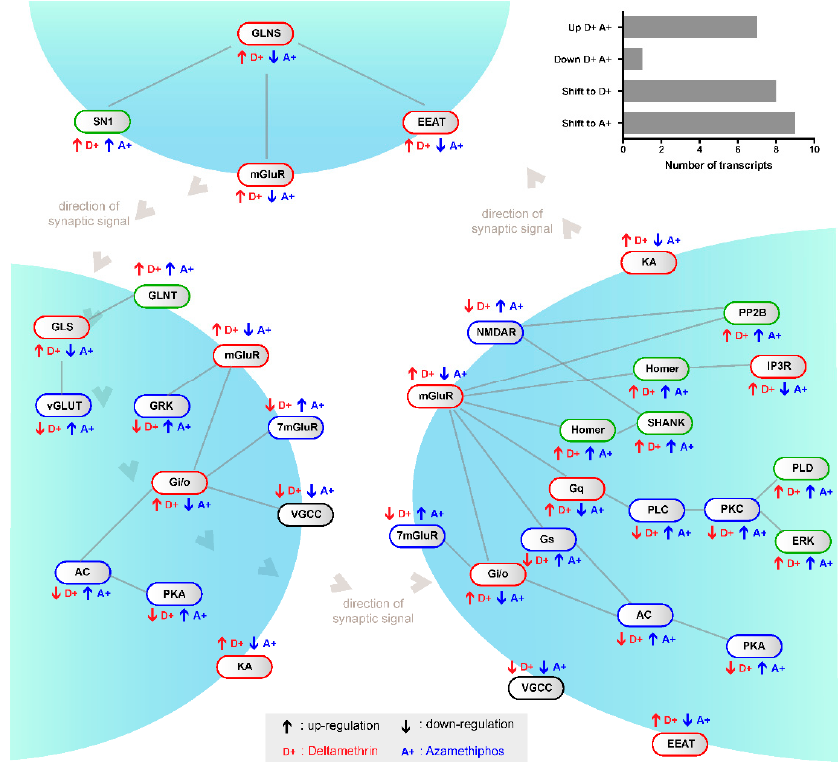
Figure 2. Modulation of glutamatergic synapse pathway transcription levels by xenobiotic drugs in Caligus rogercresseyi . Abbreviations are per established GeneCards nomenclature. Green border: genes up-regulated by both drugs; black border: genes down-regulated by both drugs; red border: genes up-regulated by deltamethrin but down-regulated by azamethiphos ( i.e. , shift to deltamethrin); and blue border: genes down-regulated by deltamethrin but up-regulated by azamethiphos ( i.e. , shift to azamethiphos).